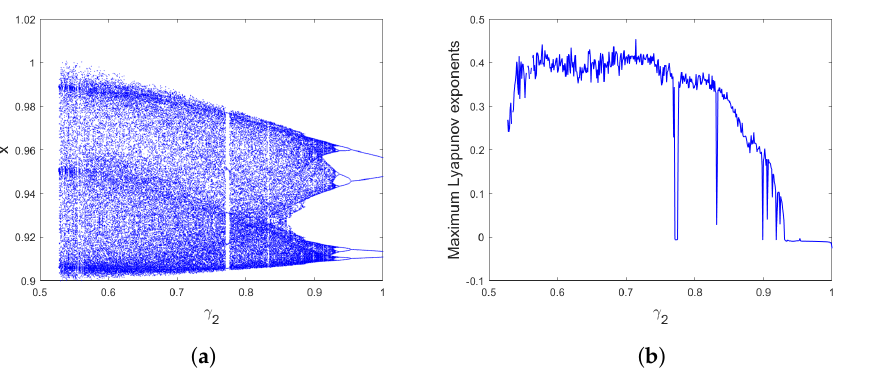
Figure 6. ( a ) Bifurcation of (11) versus γ 2 for a = 2.5, b = 5, c = 5.5, δ = 1.05 and γ 1 = 1. ( b ) The corresponding